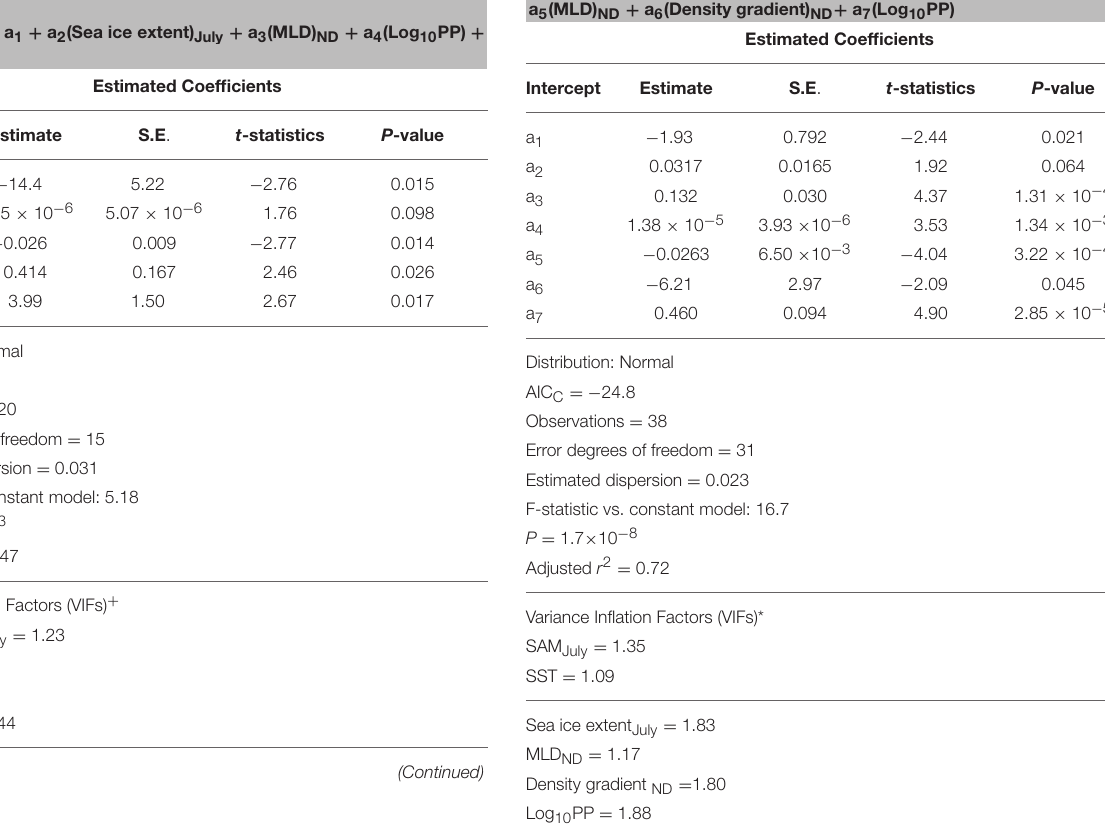
TABLE 1 | Summary of generalized linear models (GLMs) and associated statistics for monthly composites of BP during summertime only (A) and during entire growing seasons (B).